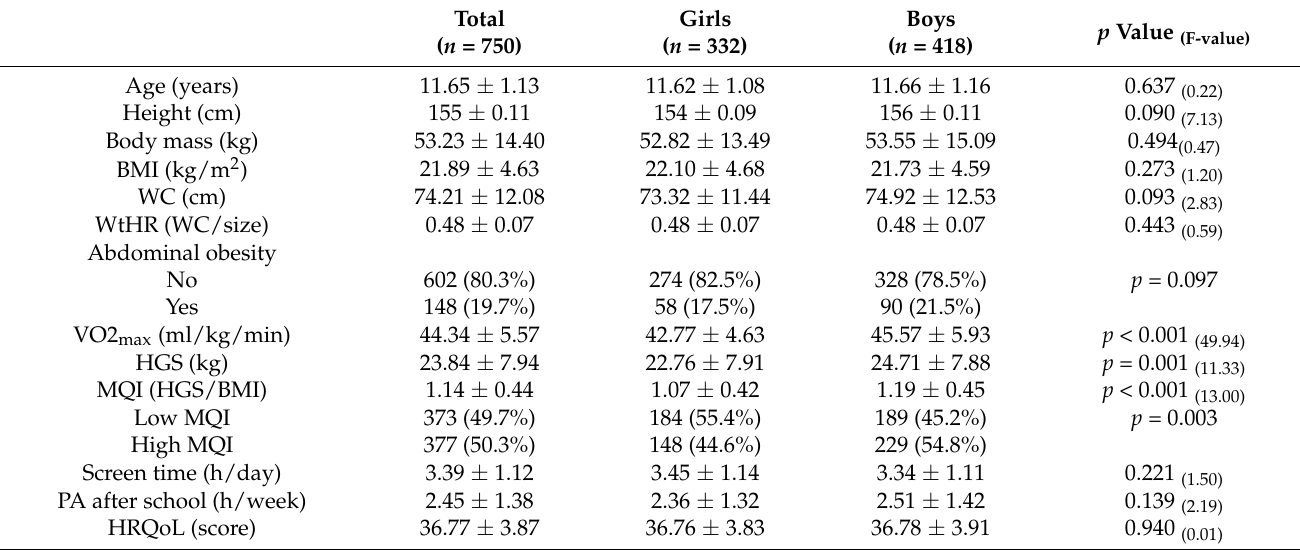
Table 1. Characteristics of sample study according to sex.